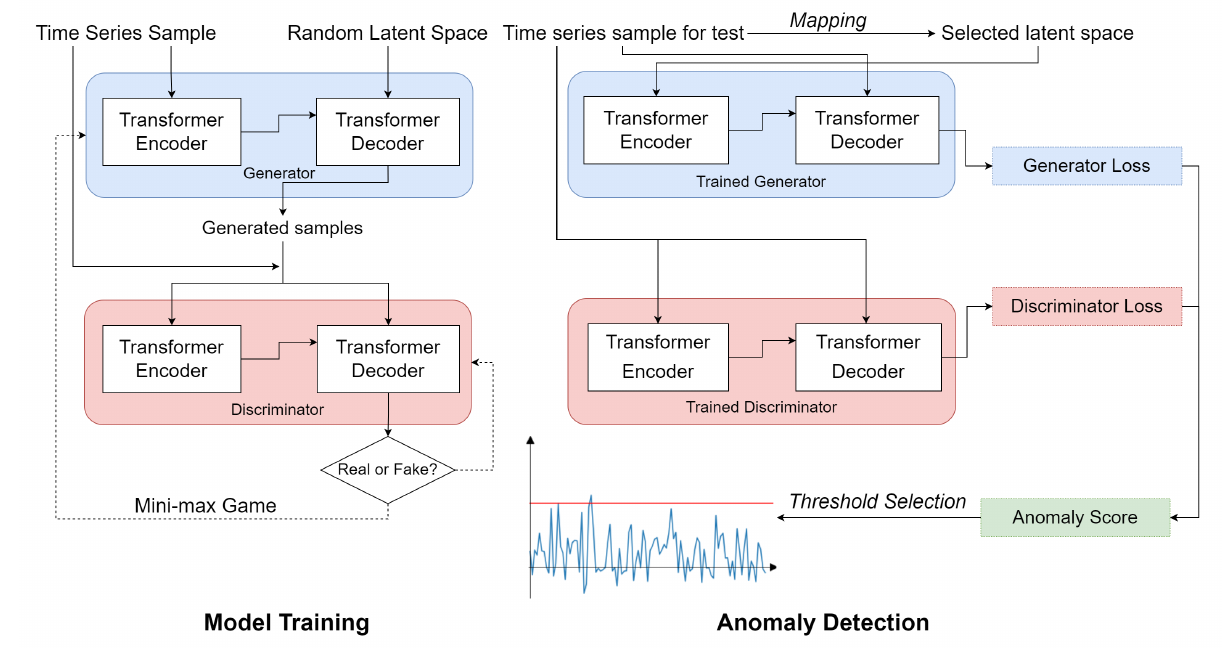
Figure 3. The overall framework of TGAN-AD. The left part is the offline training process of TGAN- AD, and the right part is the process of online anomaly detection. Both the generator and discriminator are constructed based on Transformer.